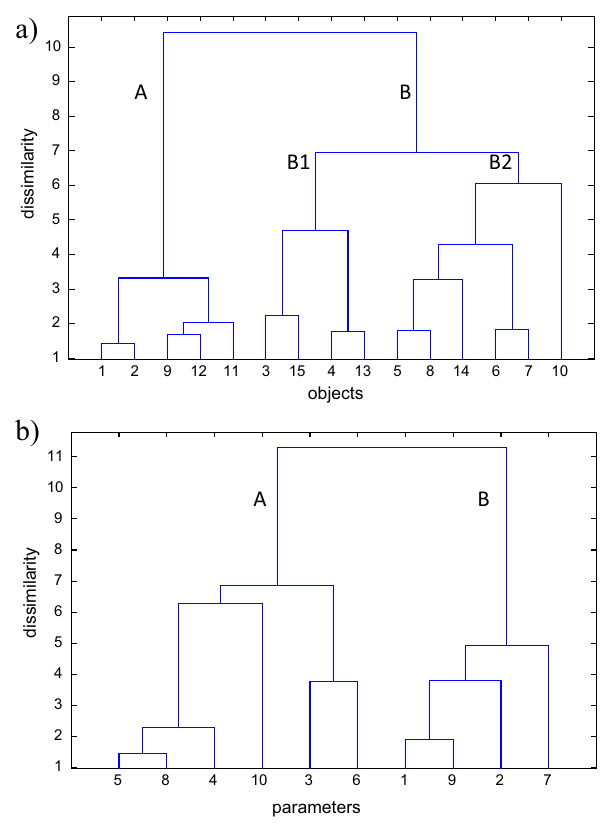
Fig. 3 Dendrograms of HCA cluster analysis. a Clustering of objects in the parameter space; b Clustering of parameters in the feature space